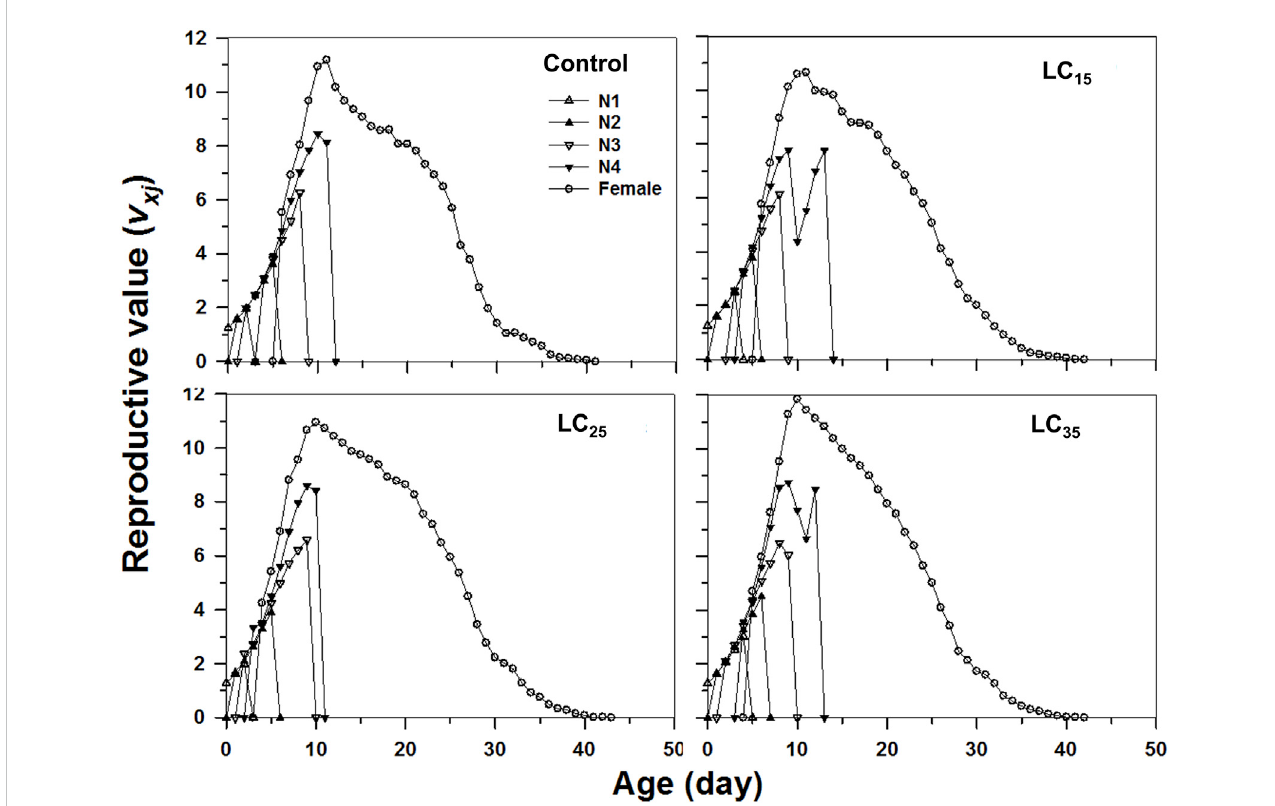
FIGURE 5 Age-stage-specifc reproductive value ( v xj ) of Metopolophium dirhodum individuals of the F1 generation under control conditions, treated with 50 mg/L of imidacloprid (LC 15 ), 100 mg/L of imidacloprid (LC 25 ) and 200 mg/L of imidacloprid (LC 35